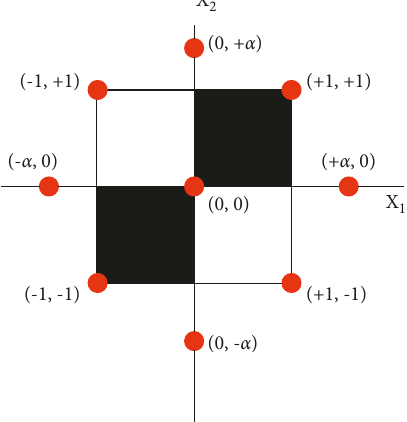
Figure 1: Center composite design with k �